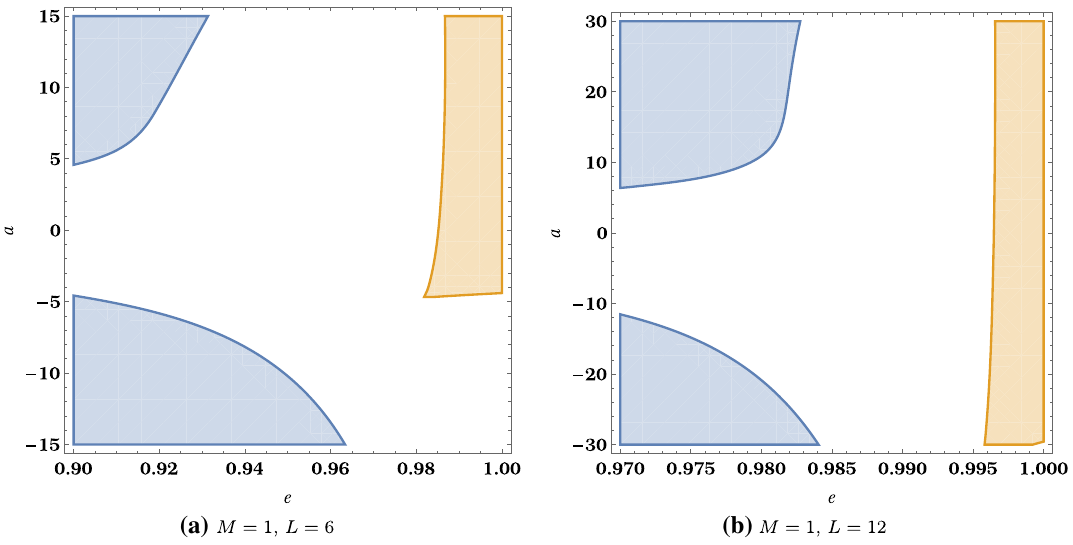
Fig. 4 This figure shows region plots of f > 0 and V min ≤ E < 0 for M=1 and L = 6 ( a ) and L = 12 ( b ). Blue region represents region of negative precession ( f > 0) and orange region represents region of bound orbits ( V min ≤ E <